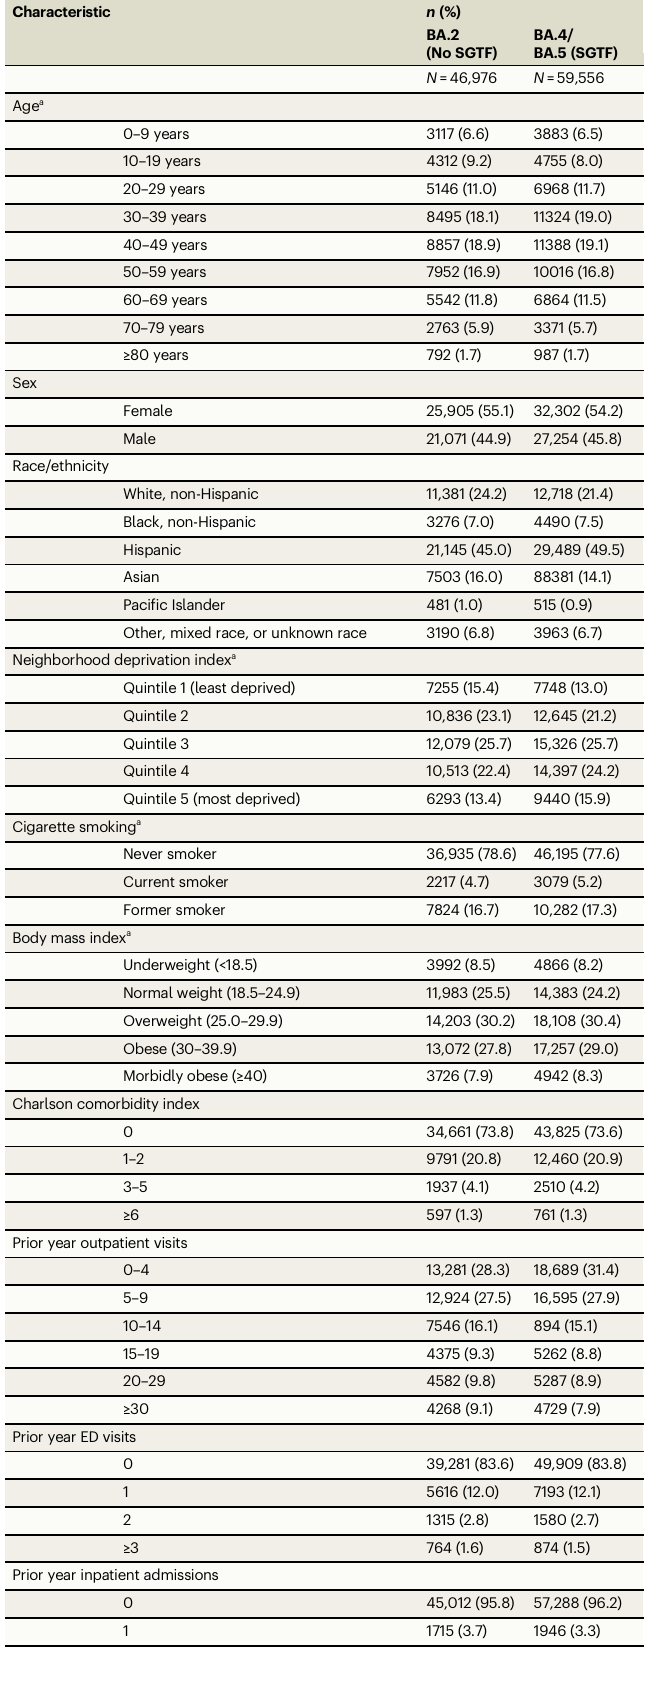
Table 1 | Characteristics of cases with BA.2 and BA.4/BA.5 lineage SARS-CoV-2 infection Characteristic